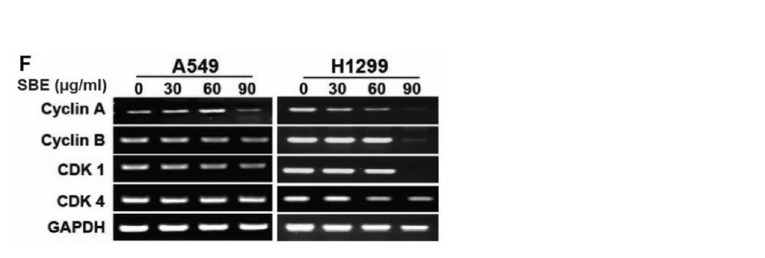
Figure 1. A corrected version of Figure 6C in the Article.